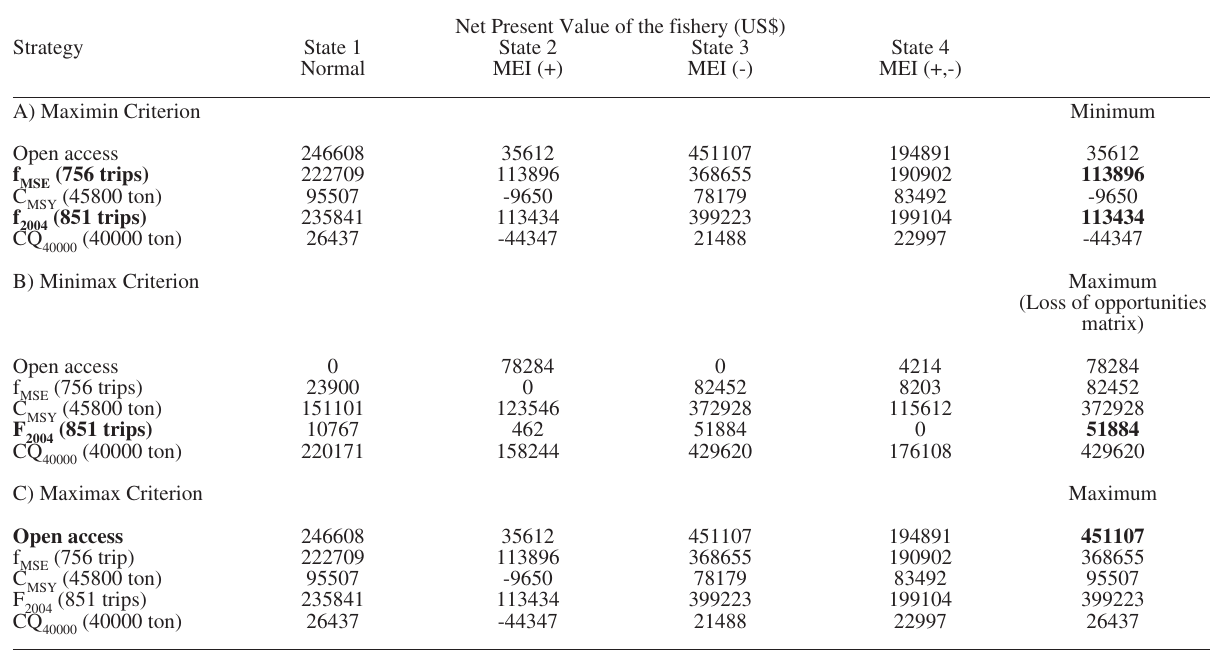
Table 4. – results of the decision analysis without mathematical probabilities but with the use of the a) Maximin, b) Minimax, and c) Maxi- max criteria, considering five management strategies with four states of nature defined by Mei a values. net Present Value of the fishery (us$)